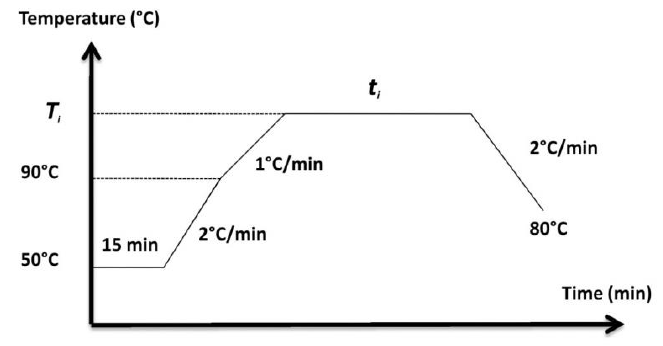
Figure 2. Dyeing process (temperature T i and time t i are parameters to be studied and optimized).